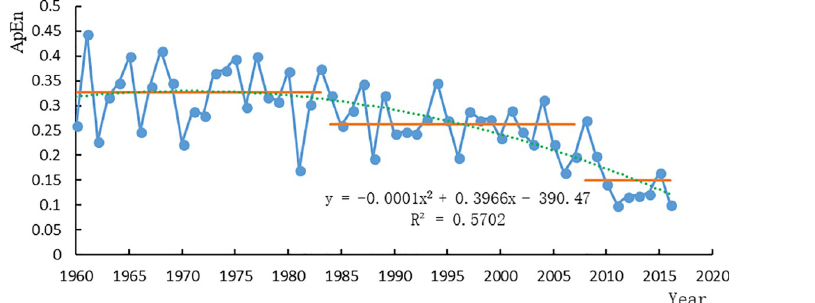
Fig 2. ApEn value process line of annual sediment discharge at Wu Long Station.